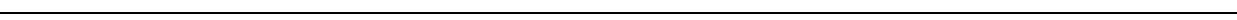
Fig. 1 Architecture and characterization of TLK2. a TLK2 domain architecture and constructs used in this study. For a complete list see Supplementary Figure 2 . b Size exclusion chromatography (SEC) coupled with Multi-Angle Laser Light Scattering (MALLS) pro fi les were used to assess the oligomerization state of the phosphorylated and unphosphorylated constructs with or without the C-tail for the kinase domain and c Δ N-TLK2 constructs. The effect of the catalytically inactive mutant Δ N-TLK-KD (D613A mutation) is also included. d The indicated TLK2 mutants were overexpressed in AD293 cells by transient transfection and pulled down from cell lysates using Streptavidin resin. Protein – protein interactions were analyzed by western blotting for TLK2, TLK1, ASF1 and LC8 (right panel). Input levels are shown in the left panel including the Ponceau red-stained membrane showing similar total protein levels. The KD in this experiment bears the D592V mutation instead of D613A. e Kinase assays were performed from Streptavidin pull-downs performed as in d . Kinase complexes were incubated with either MBP or ASF1a in the presence of 32 P-ATP and autophosphorylation (TLK2) and substrate phosphorylation assessed in dried SDS-PAGE gels exposed to a phosphoimager. f Immuno fl uorescence analysis of exogenous TLK2 in transiently transfected AD293 cells. Localization of TLK2 and mutant forms was determined by staining with anti-FLAG antibodies and co-staining of nuclei with DAPI. Cytoplasmic localization of the Δ N-TLK2 mutant con fi rms the presence of the NLS in the N-terminus of the protein. The scale bar represents 10 μ m in all the pictures. Uncropped gels and blots are shown in Supplementary Figures 10 –